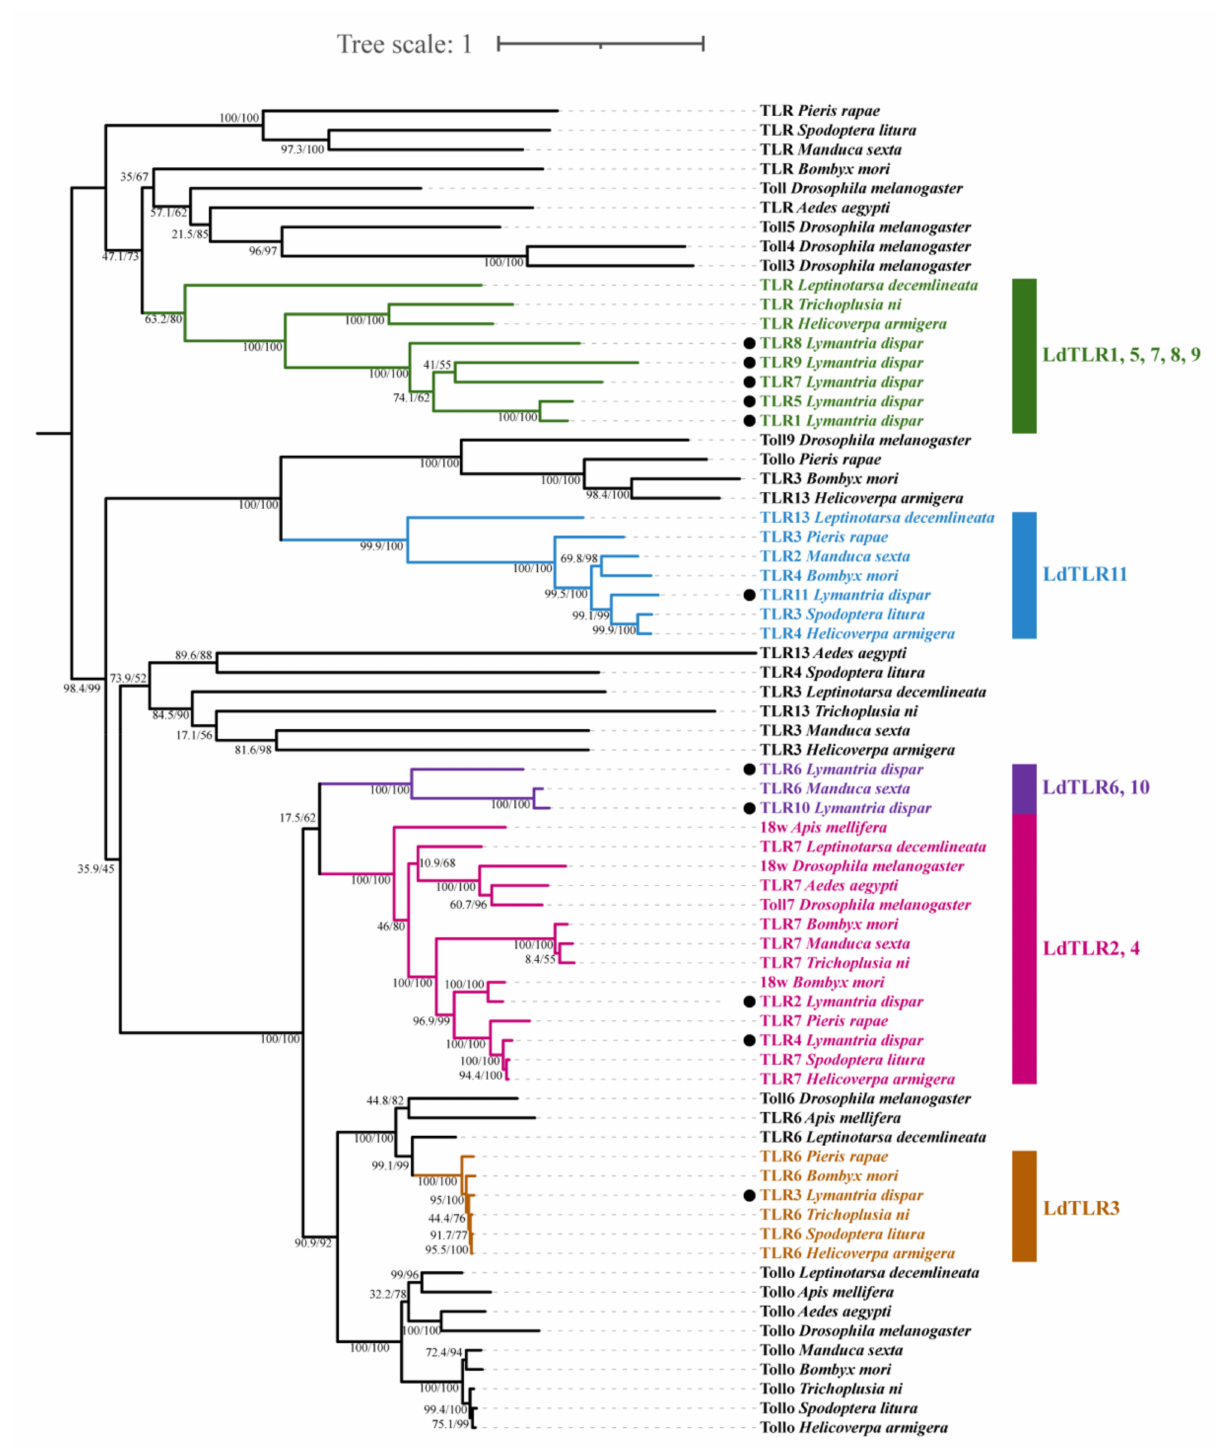
Figure 4. A phylogenetic tree of insect TLR proteins from the related species. Bootstrap support values and SH-aLRT values are indicated on branches. The tree was rooted by midpoint approach. Eleven LdTLRs were marked by black dots. Five clusters including LdTLRs are marked by different